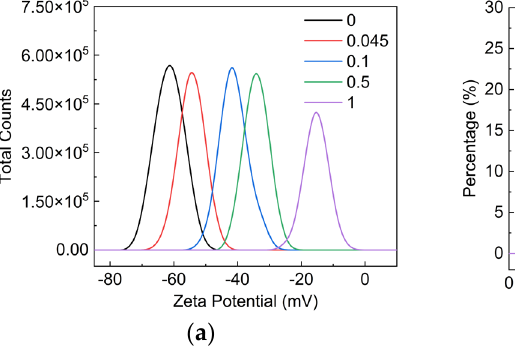
Figure 3. Characterization of SA/PEI dispersion with weight ratio of PEI to SA. ( a ) Zeta potential, ( b ) hydrodynamic size distribution and ( c ) average Zeta potential and hydrodynamic size of SA/PEI dispersion.